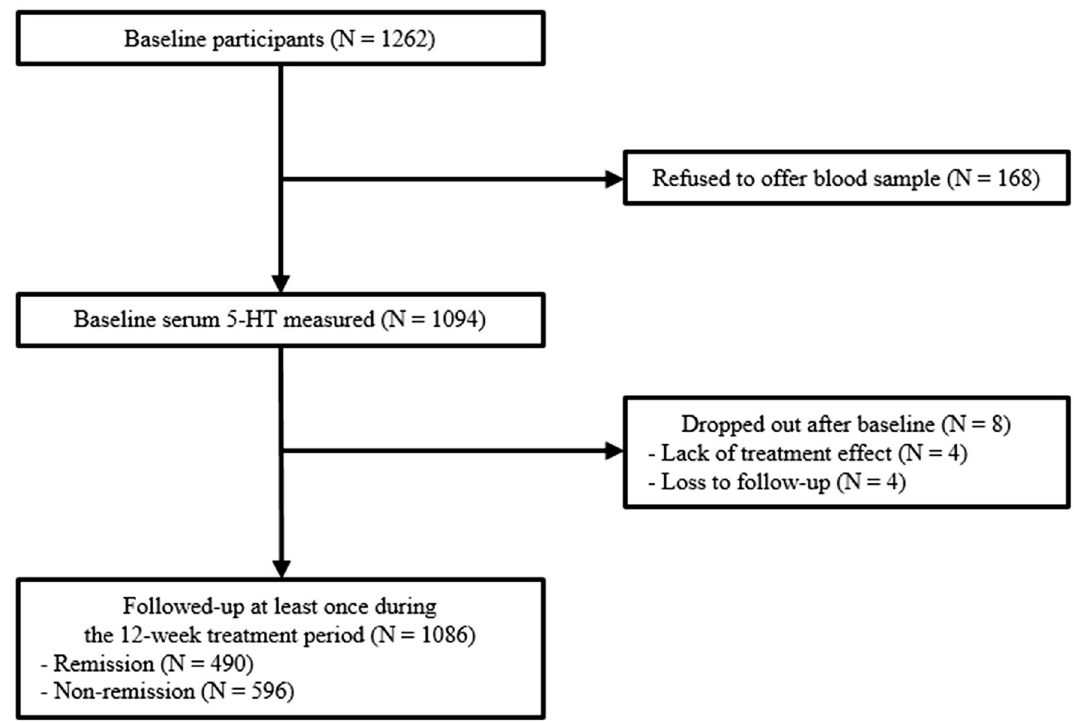
Figure 1. Participant recruitment and